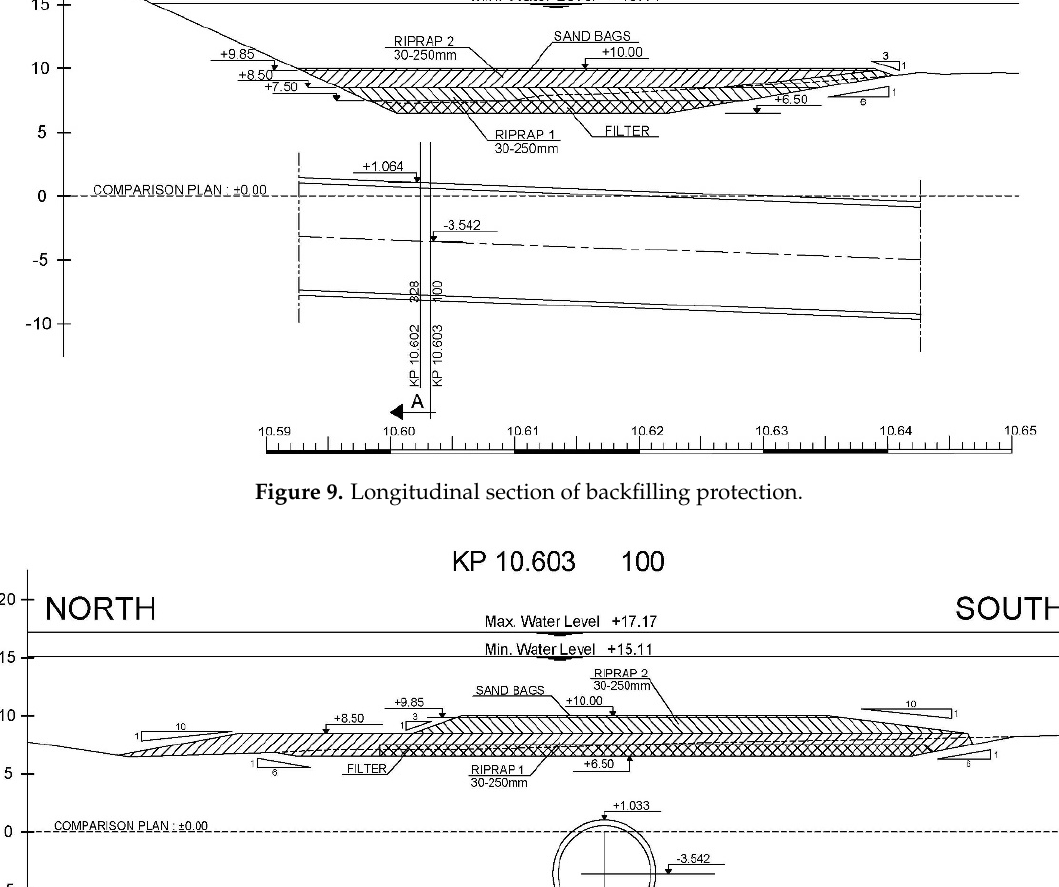
Figure 9. Longitudinal section of backfilling protection.